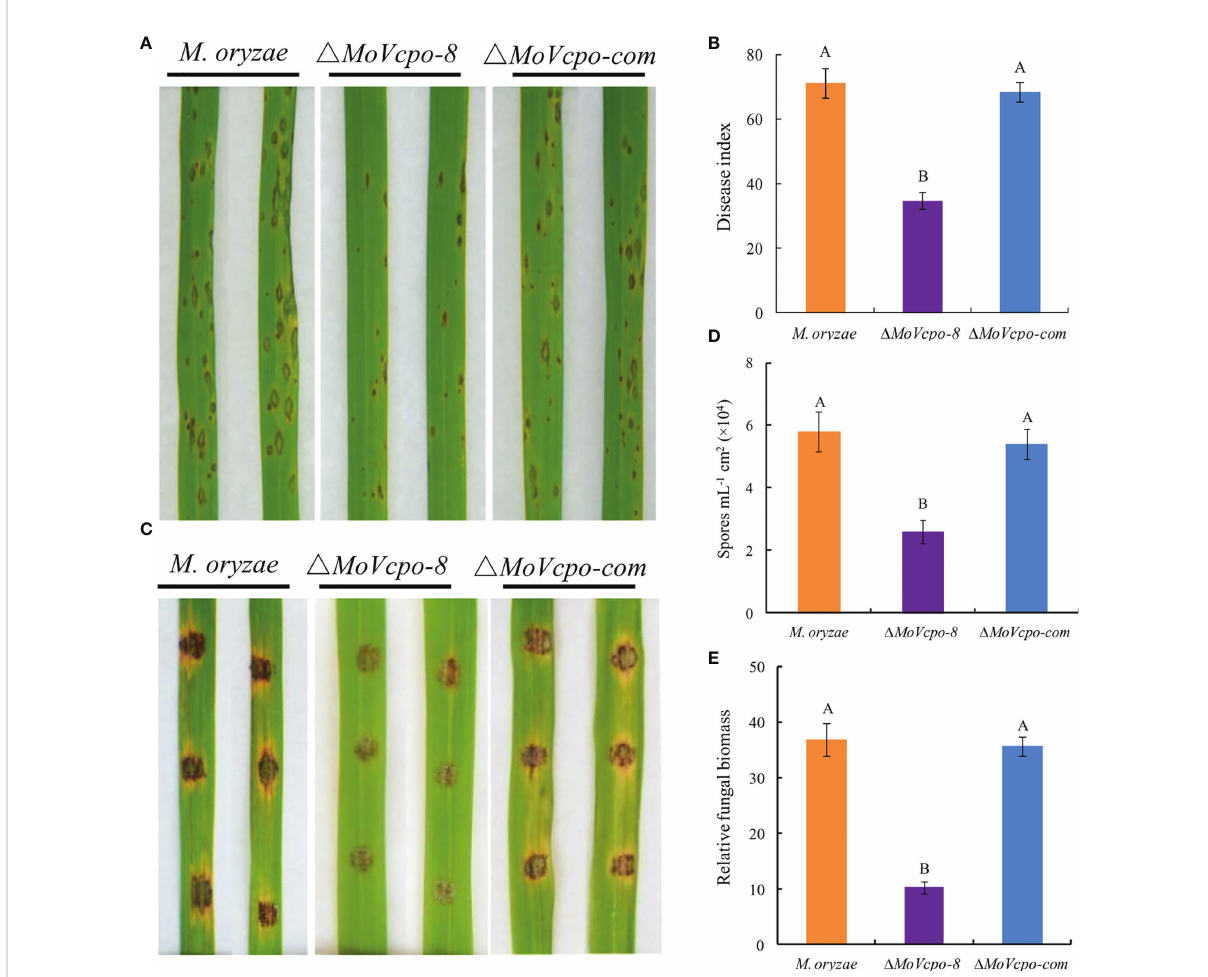
FIGURE 9 Pathogenicity assay of MoVcpo deletion mutant and complementation strain. (A) Virulence bioassay on rice cultivar cv. CO39 conducted by the spraying inoculation method. The symptoms of rice plants were investigated 7 dpi and photographed. (B) Disease index of rice blast in spraying inoculation bioassay. (C) Virulence bioassay on rice plants conducted by the punch inoculation method. Leaves were photographed 10 dpi. (D) Sporulation on the punch-inoculated leaves. Samples were taken for the assays 10 dpi. (E) Relative biomass assay on the punch-inoculated leaves. The relative fungal growth was measured by [2 [CT( OsUbiquitin )-CT( MoPot2 )] ×10000] using DNA-based qPCR. Rice seedlings at the fourth-leaf stage were inoculated with the conidial suspensions (1×10 5 conidia/mL) of the wide type, MoVcpo deletion mutant, and complementation strain. Values are the means from three independent experiments and bars indicate standard deviations. The letters above the bars are signi fi cantly different at 0.01 level using Duncan ’ s multiple range